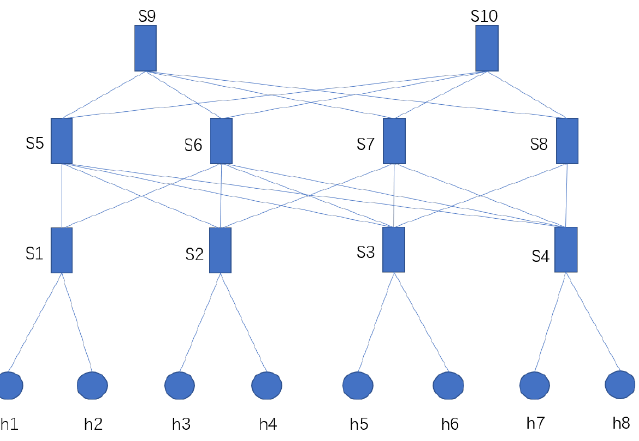
Figure 1. Three-layer non-blocking fully populated network model.